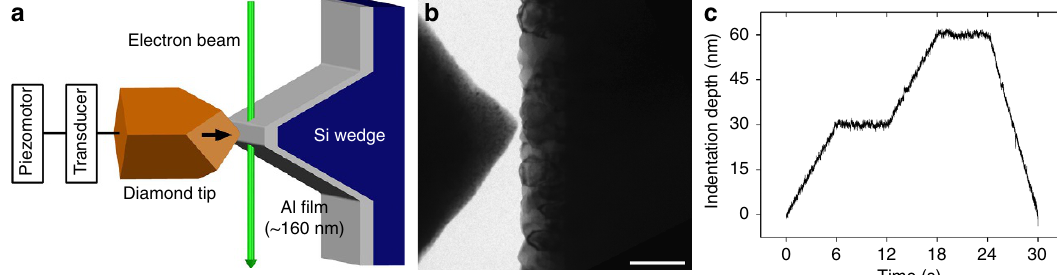
Figure 2 | Layout of quantitative in situ TEM indentation tests. ( a ) Schematic of experimental set-up showing thin film deposited on a wedge-shaped substrate to enable electron transparency at the wedge apex, as well as provisions for instrumented measurements and alignment. ( b ) Bright-filed TEM image of diamond tip and NC Al film on Si wedge substrate. Scale bar, 200nm. ( c ) Loading and unloading profiles for a representative test.